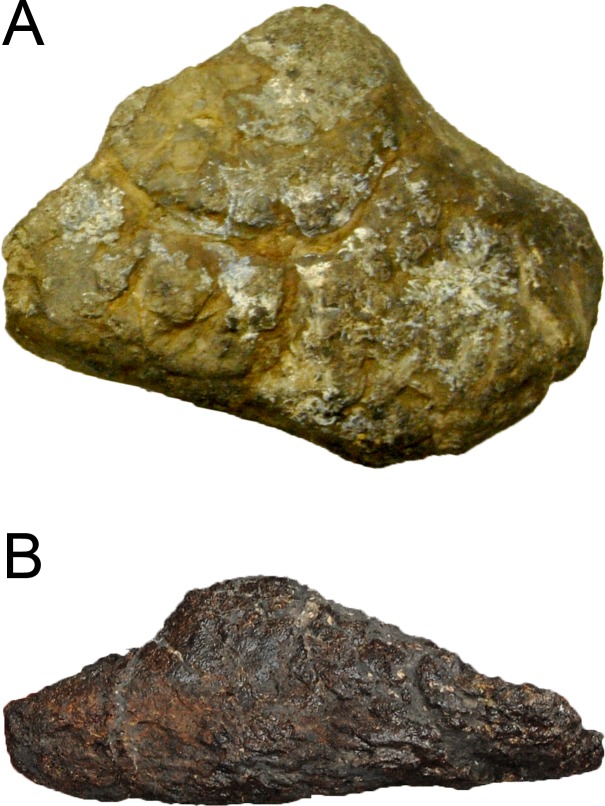
Diplodocid metatarsal V.Metatarsal V of Barosaurus affinis YPM 419 (A) and SMA 0087 (B) in proximal view, illustrating the rhomboid (A; C471-1) or triangular outline of the articular surface (B; C471-0). Scaled to the same transverse width.